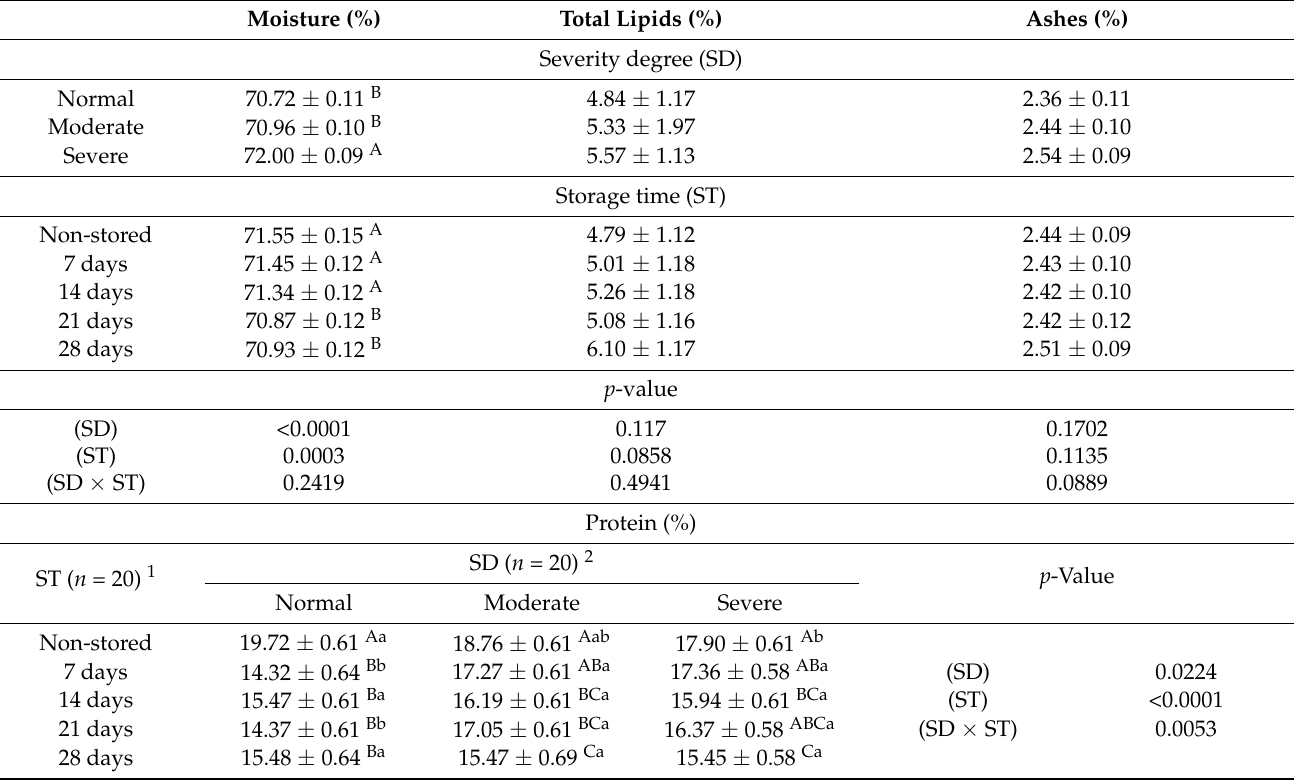
Table 2. Mean values of moisture, total lipids and protein concentrations in fresh sausages produced with breast meat from Ross (AP95) broiler chickens without myopathies and affected by wooden breast myopathy after different storage